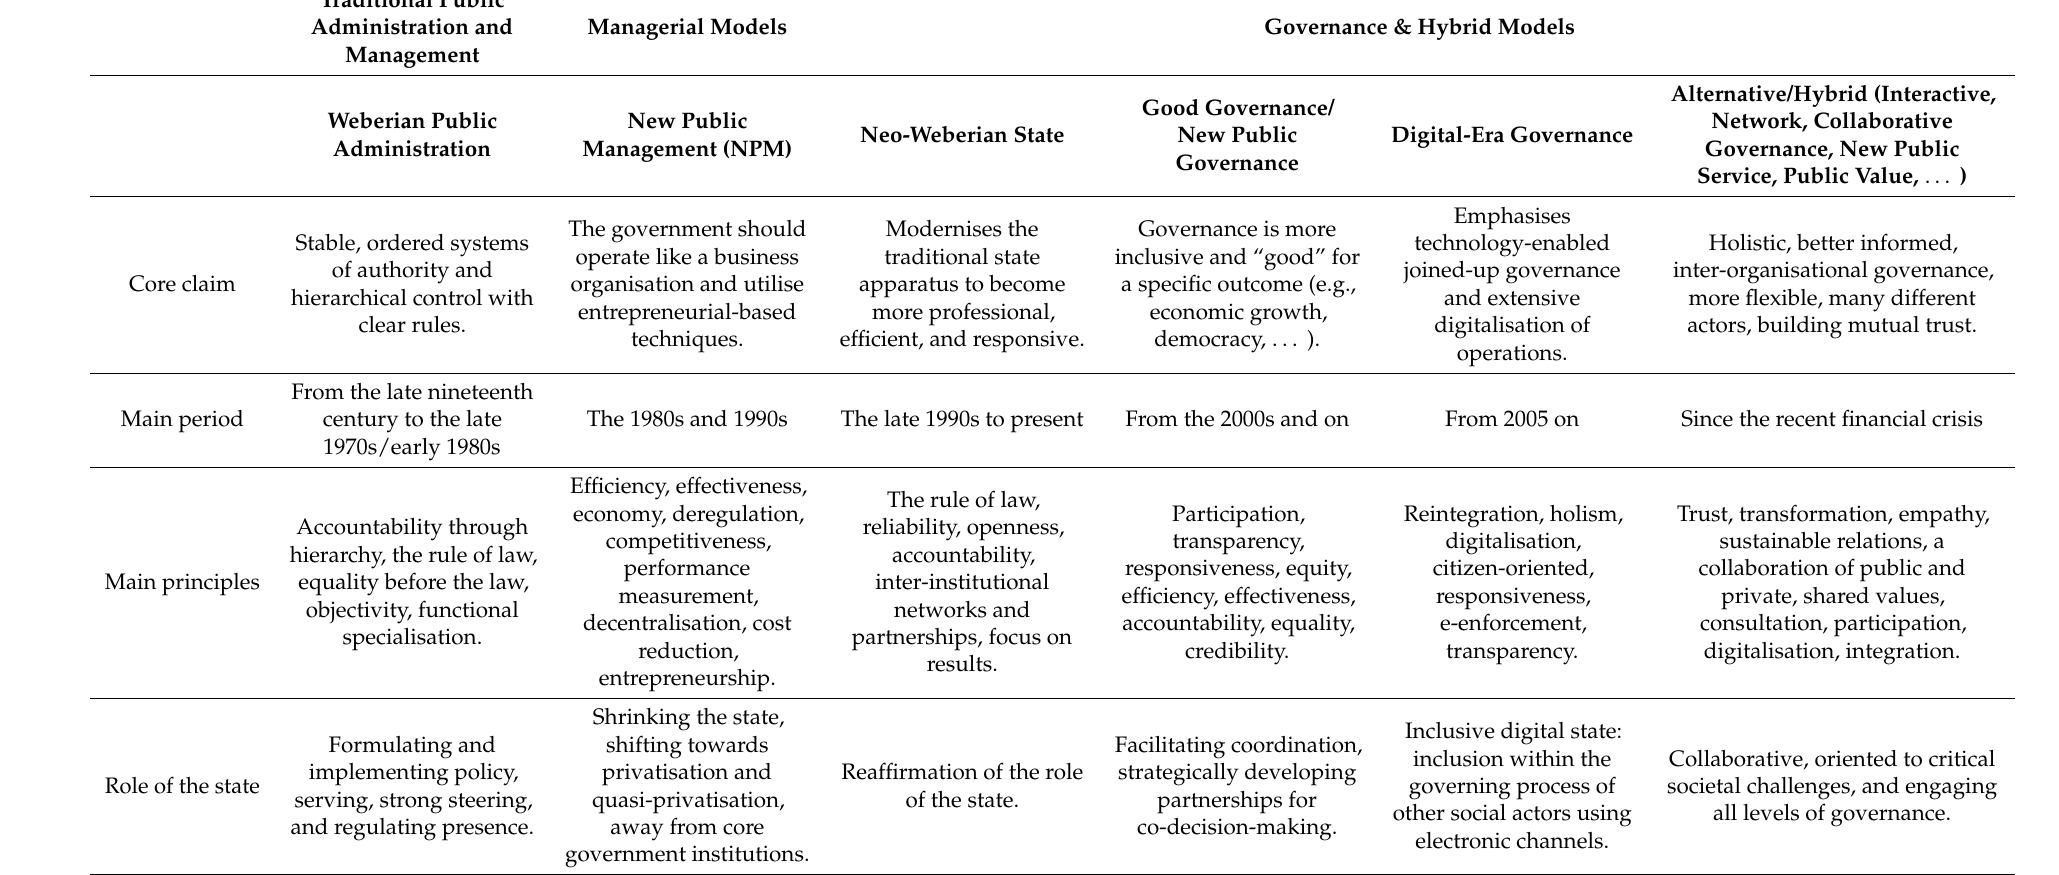
Table 1. Summary of the literature review on public governance